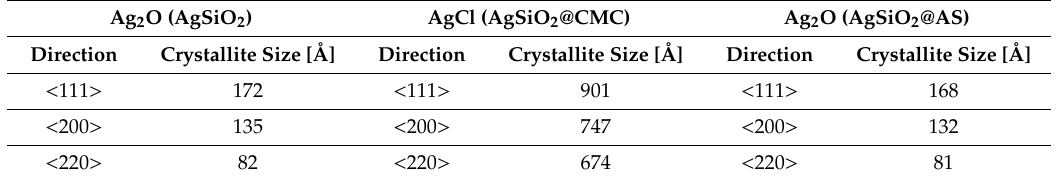
Table 2. The crystallite sizes were estimated based on the XRD